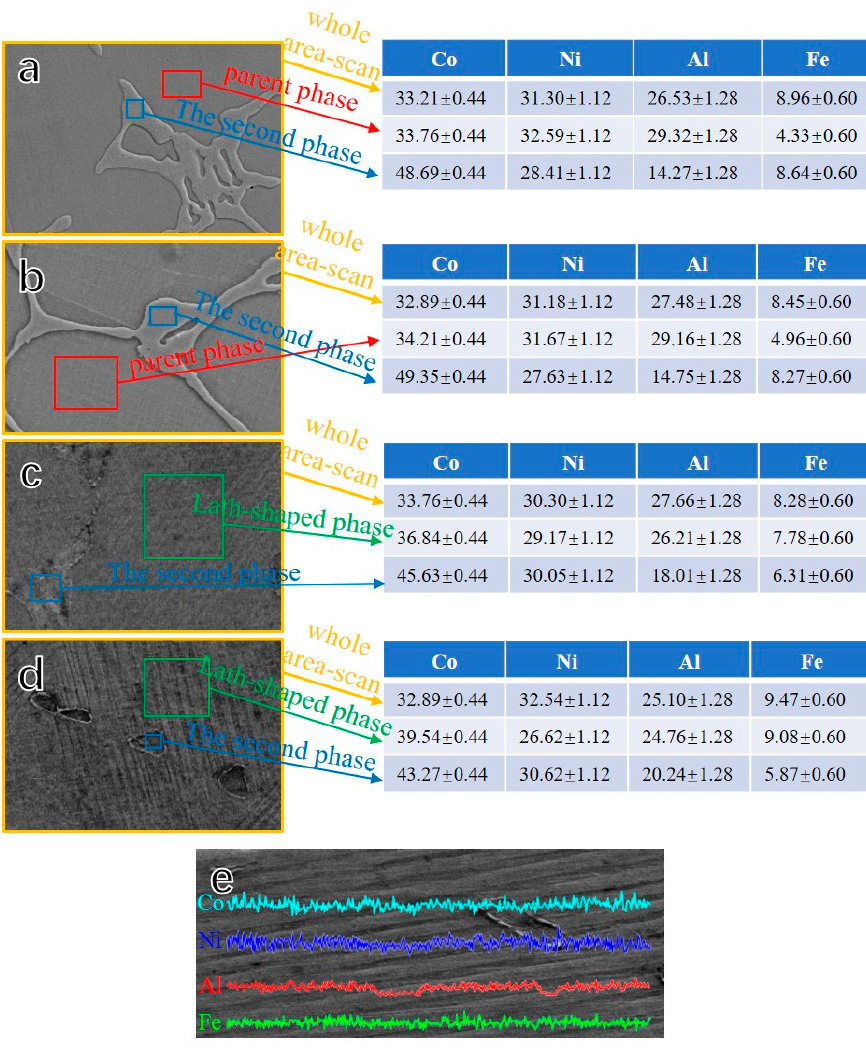
Figure 3. The X-ray spectrometry test of of the Co 33 Ni 31 Al 27 Fe 9 alloy with furnace cooled and RS: ( a ) furnace cooled; ( b ) D8; ( c ) D4; ( d ) D1; ( e ) EDS line scanning of lath-shaped phase.